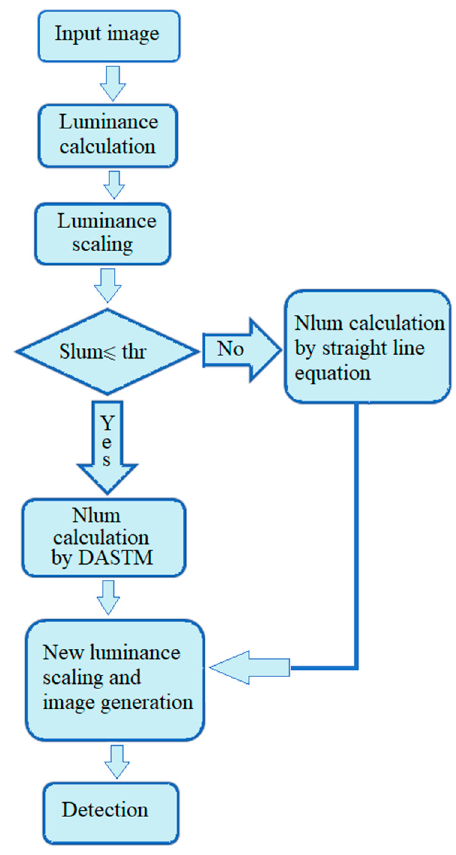
Figure 6. Flow diagram of the new Intelligent Traffic Sign Recognition System.